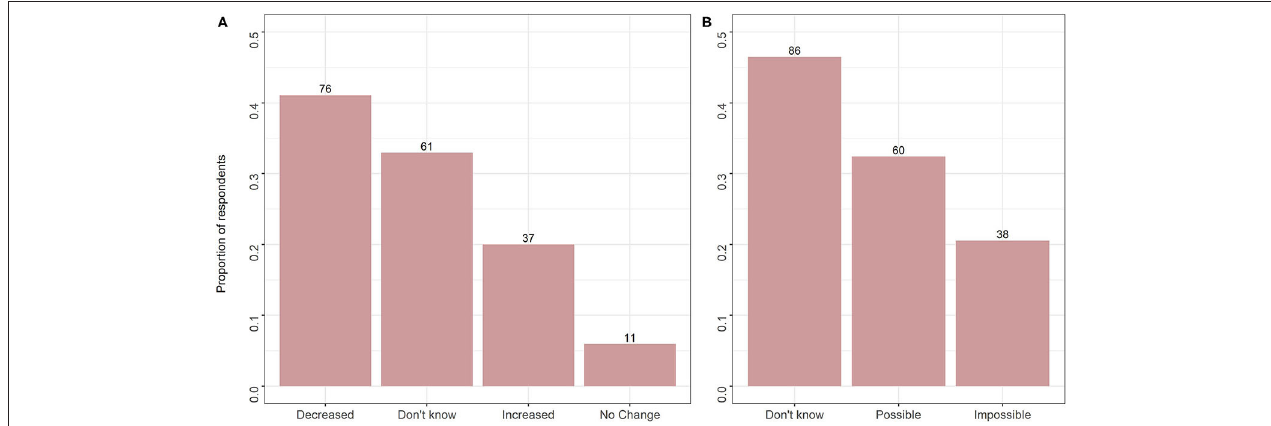
FIGURE 2 | (A) Interviewees’ perceptions of change in wildlife populations over the time they have lived in their village ( n = 185). ( B ) Interviewees’ perceptions of whether extinction of wildlife is possible or not ( n = 184).